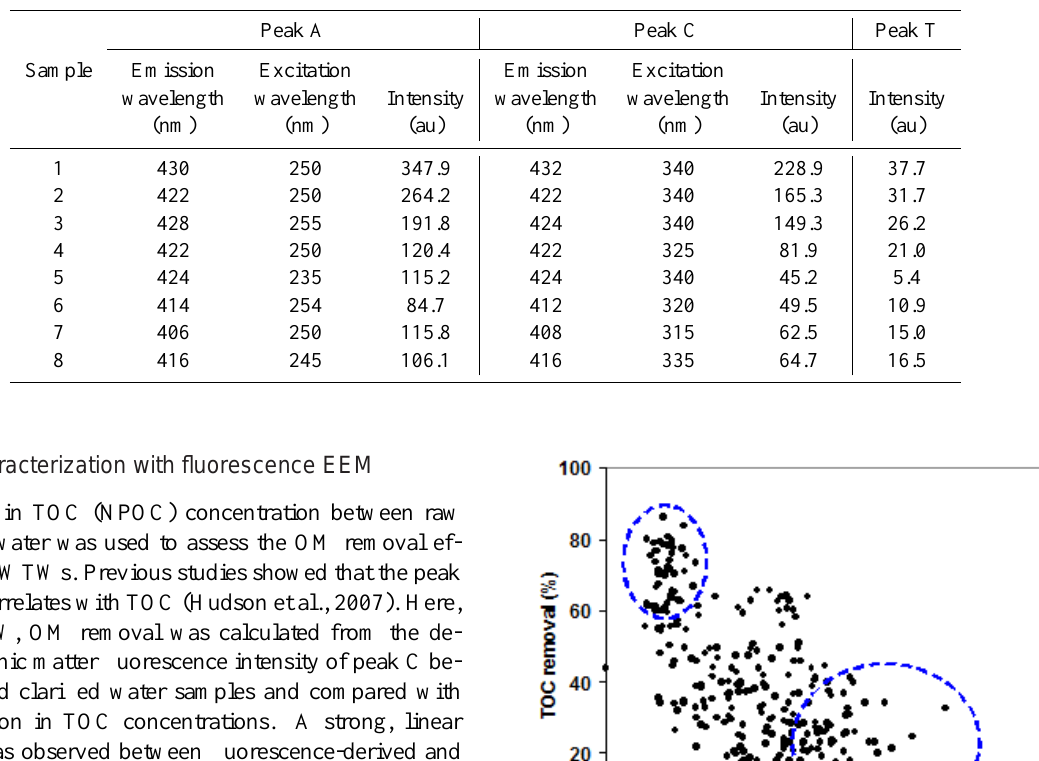
Table 1. Excitation-emission matrices of raw (1), clarified (2), filtered (3), post-GAC water (4), pre-contact tank (5), post contact tank pre de-chlorination (6), post contact tank post de-chlorination (7), and final water (8). Site 13, 05.08.07.